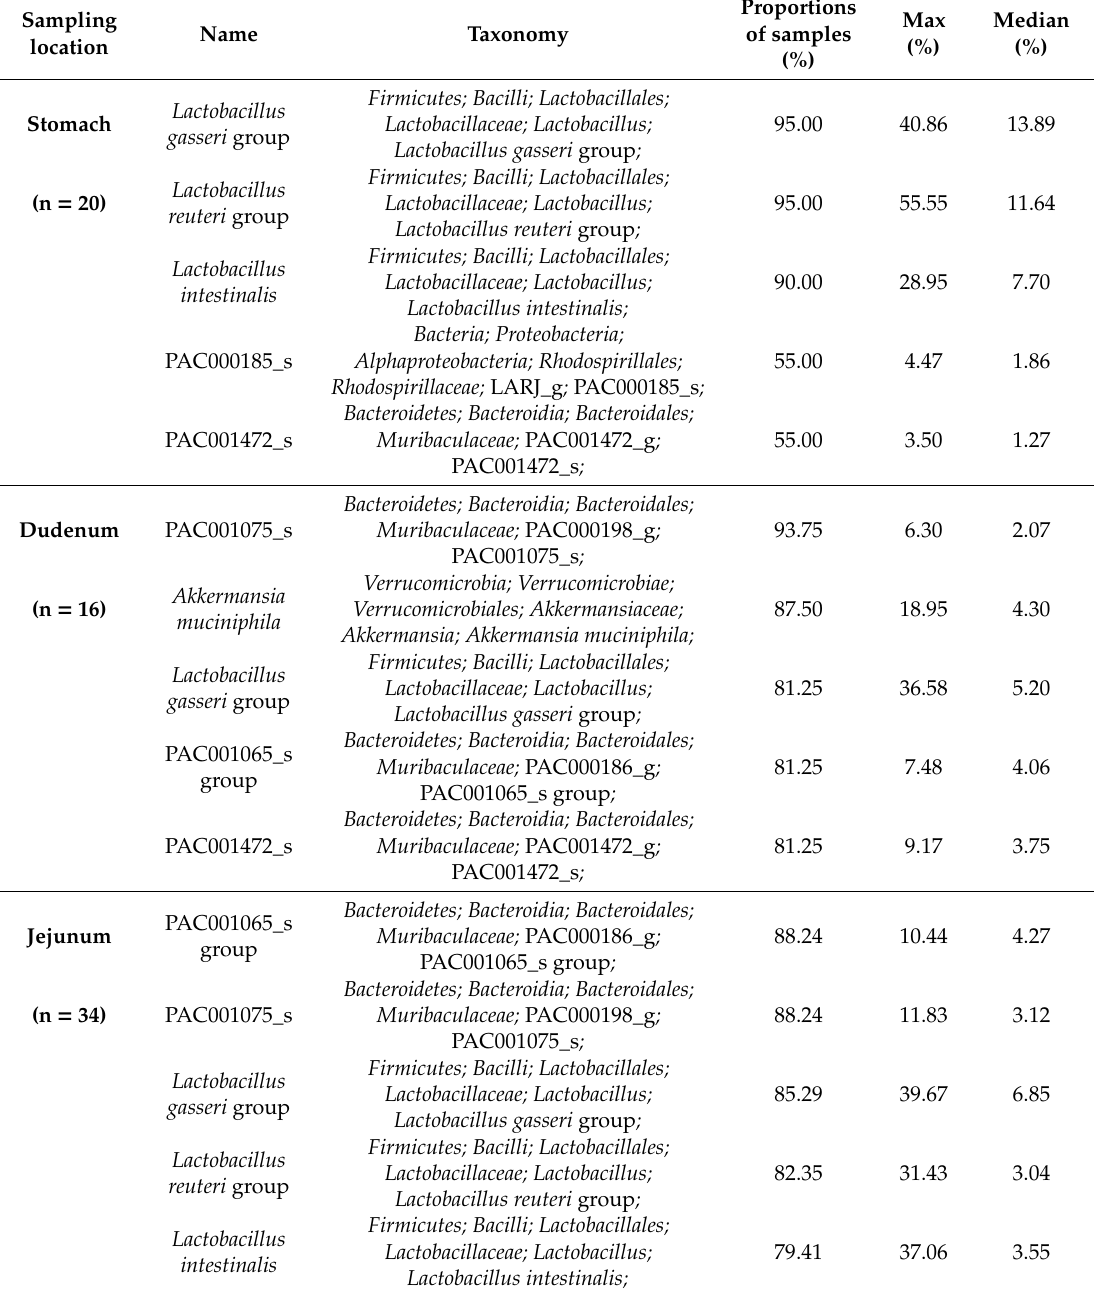
Table 2. Top five most frequently found bacterial species in the gastrointestinal tract of healthy laboratory mice. Values were calculated by considering samples with at least 1% relative